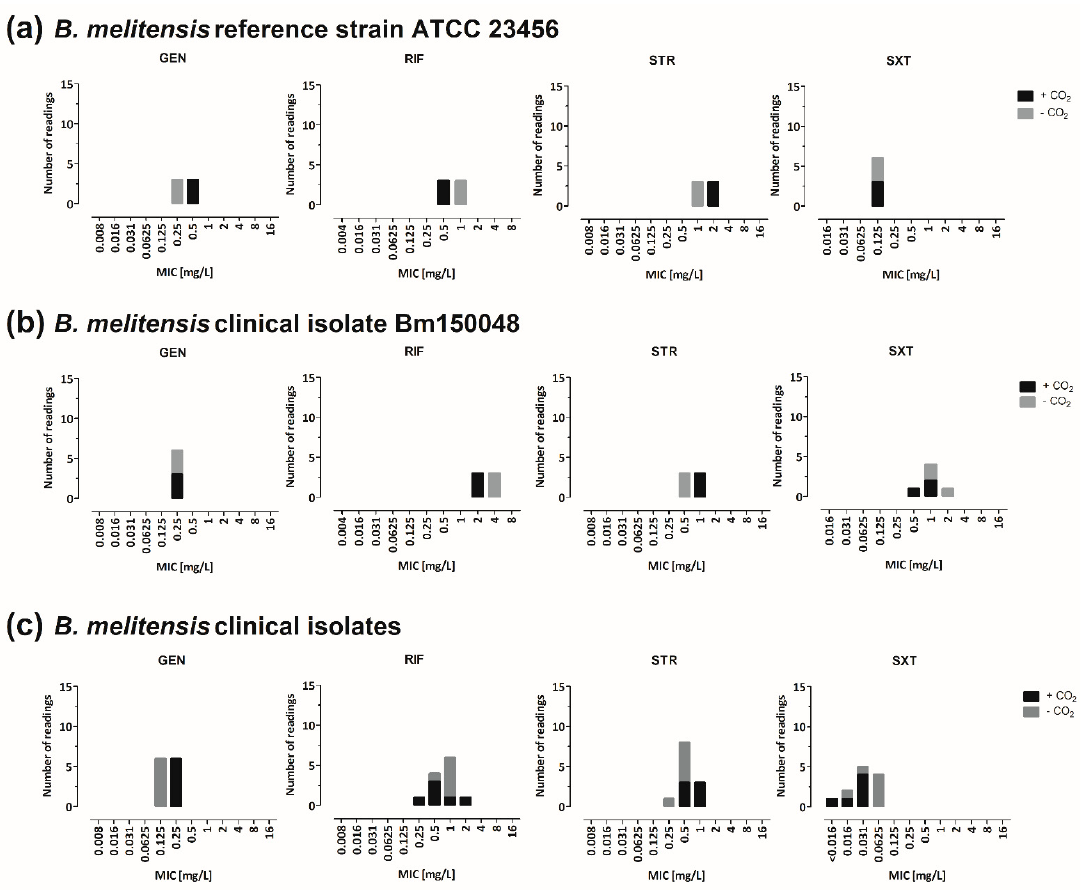
Figure 5. Impact of the incubation atmosphere on the MIC values. The MIC values were determined after incubation with or without 5% CO 2 for 48 h. ( a ) B. melitensis reference strain ATCC 23456. ( b ) B. melitensis clinical isolate Bm150048. ( c ) Six clinical B. melitensis isolates. Aminoglycoside’s MIC values were higher with 5% CO 2 (gentamicin: 0.125 to 0.25 mg/L vs. 0.25 to 0.5 mg/L, streptomycin: 0.5 to 1 mg/L vs. 0.5 to 2 mg/L), whereas the MIC values for rifampicin and trimethoprim– sulfamethoxazole were higher without CO 2 (rifampicin: 0.5 to 4 mg/L vs. 0.25 to 2 mg/L,